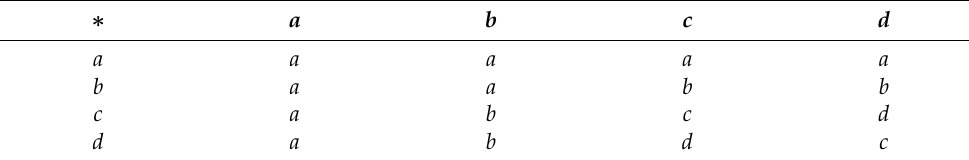
Table 3. A commutative CA-groupoid of Example